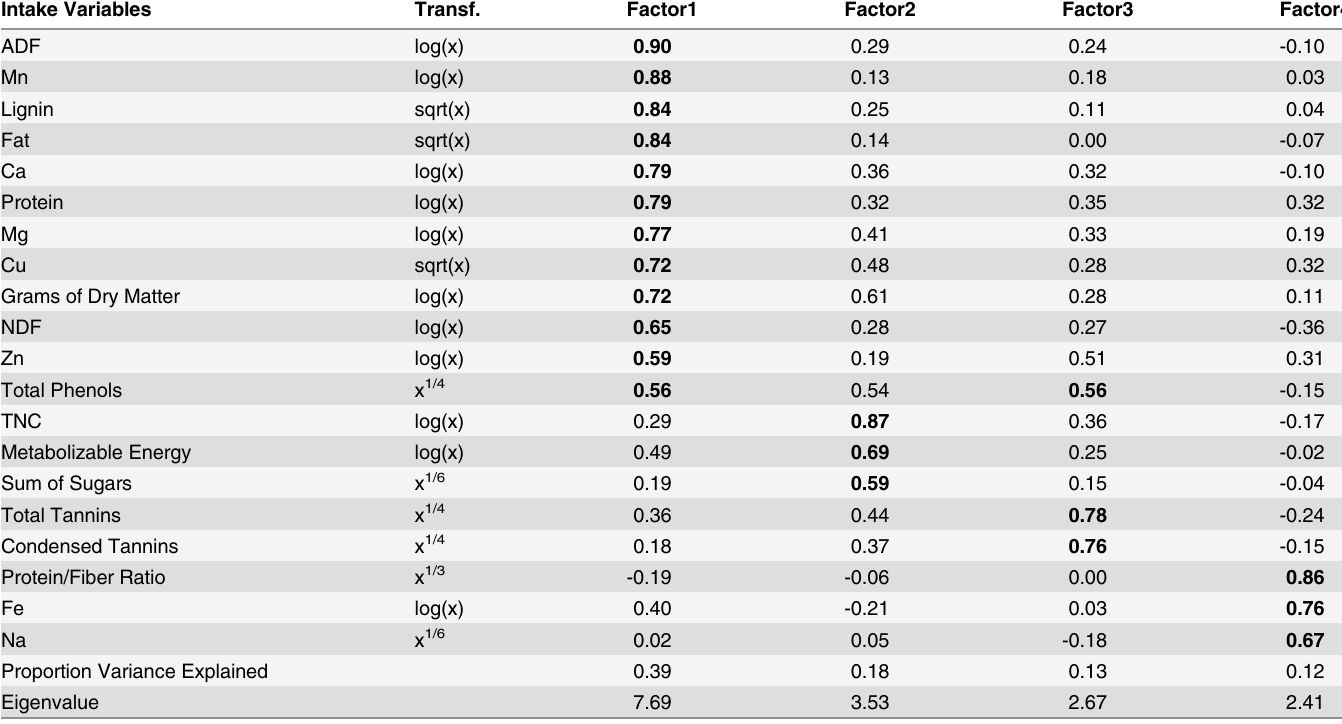
Table 3. Results of the Principal Components Analysis of energy, nutrient and antifeedant intakes by the gorillas. Intake Variables Transf.